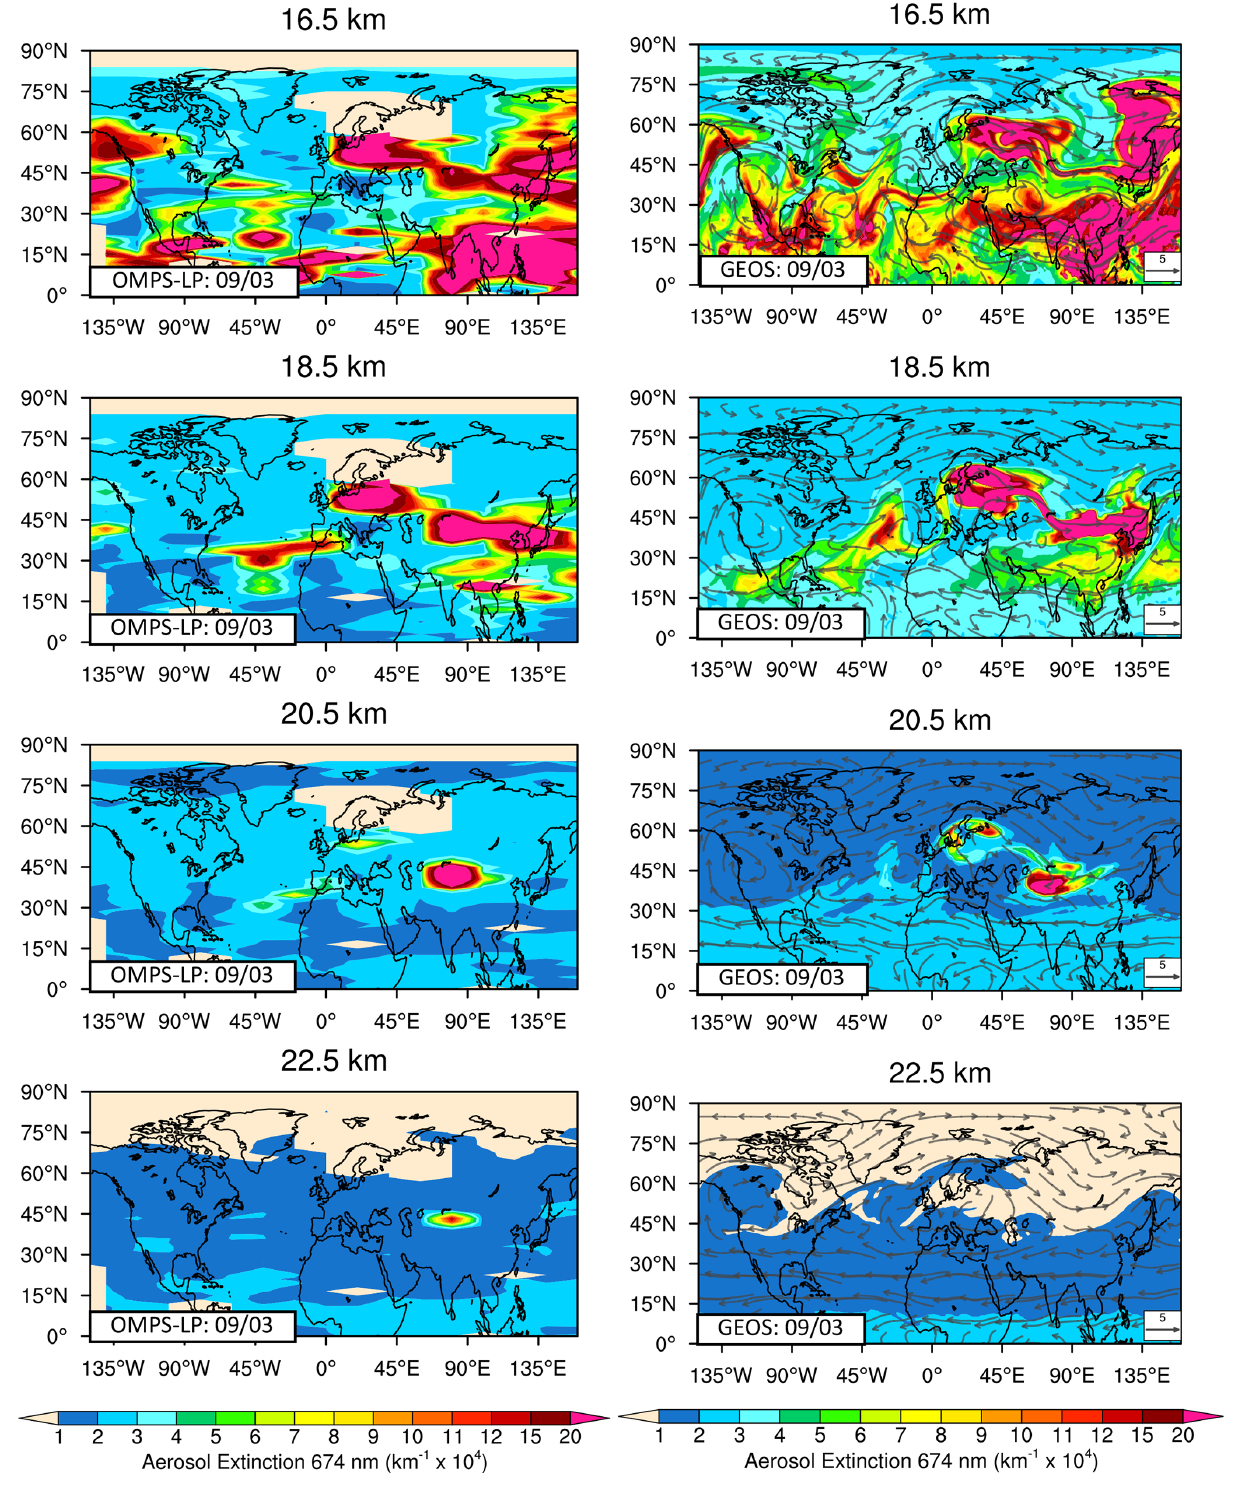
Figure 7. Horizontal and vertical transport of smoke plumes. This is the same as Fig. 6 but 3 weeks after the pyroCb injection. The model wind vectors demonstrate the role of large-scale flow in the horizontal and vertical transport of stratospheric smoke plumes, especially over the ASMA region (15–45 ◦ N and 40–110 ◦